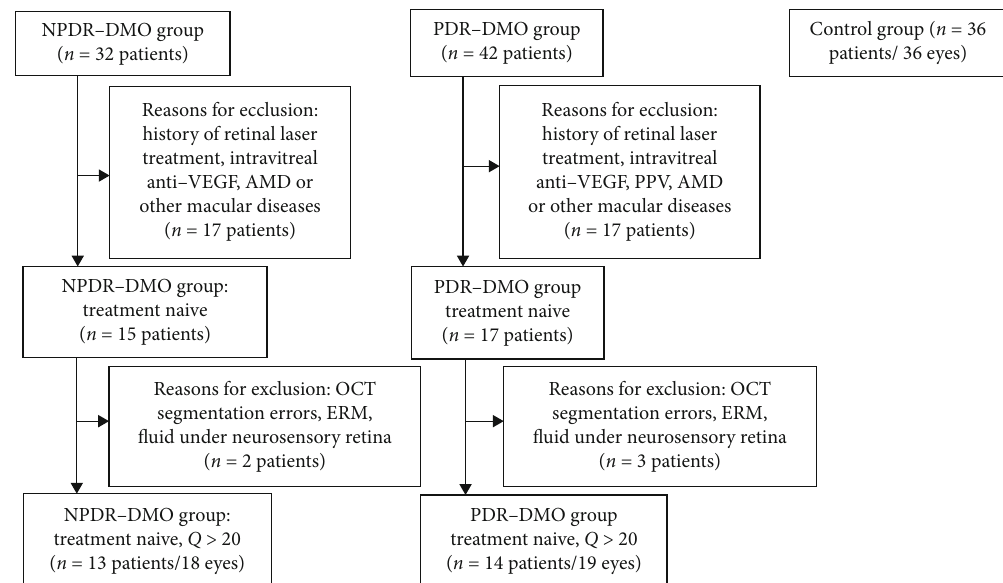
Figure 1: Flow diagram illustrating the study selection process. AMD: age-related macular degeneration; anti-VEGF: anti-vascular endothelial growth factor; PPV: pars plana vitrectomy; ERM: epiretinal membrane, Q: OCT segmentation quality; NPDR-DMO: nonproliferative diabetic retinopathy-diabetic macular oedema; PDR-DMO: proliferative diabetic retinopathy-diabetic macular